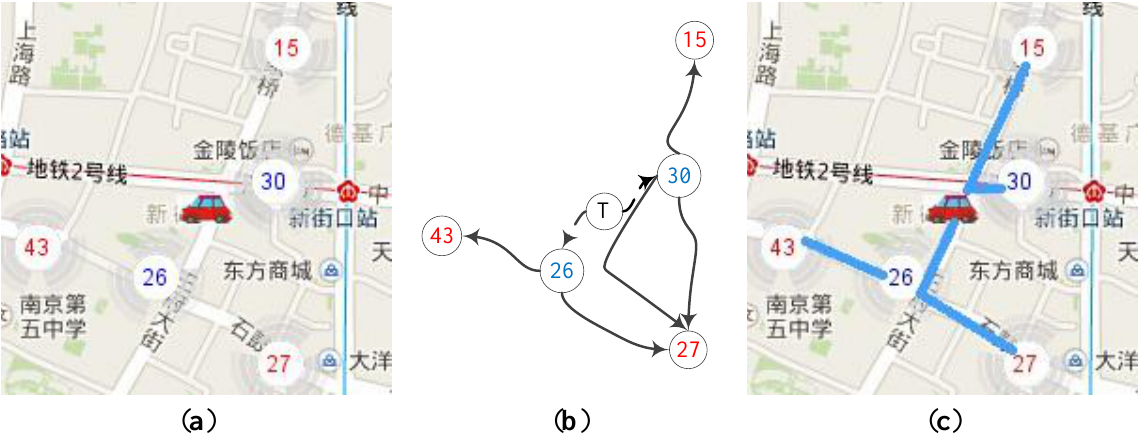
Figure 4. ( a ) Taxi hunting for loading hot spot; ( b ) Hot spot based model; ( c ) Trajectory